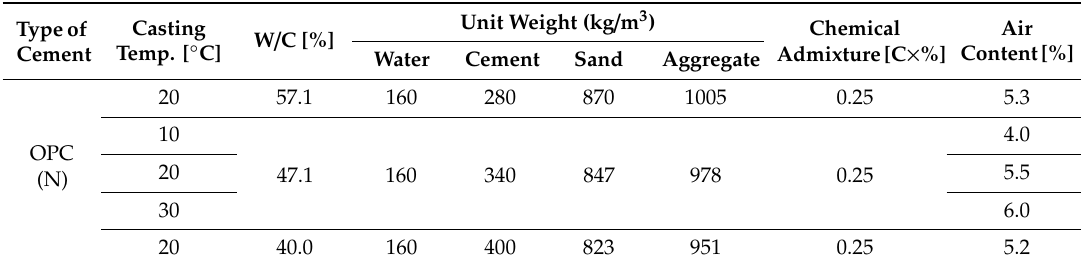
Table 3. Details of the mixtures and the experimental conditions in the adiabatic mass temperature rise tests